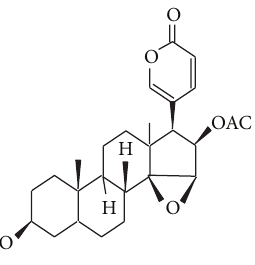
Figure 1: Structure of